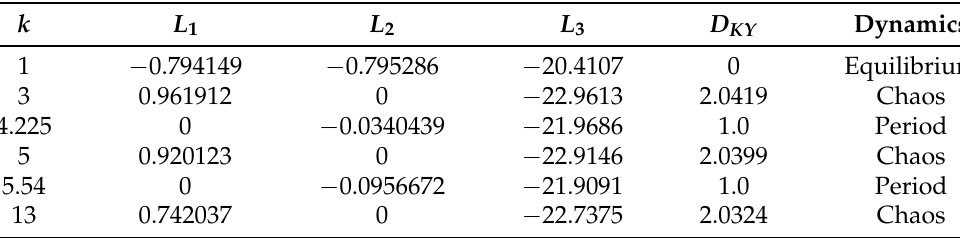
Table 1. Lyapunov exponents and Kaplan–Yorke dimension of system (2): ( a , b , c ) = ( 12,100,10 ) and ( x ) = ( 1,1,1 ) . 0 , y 0 , z 0